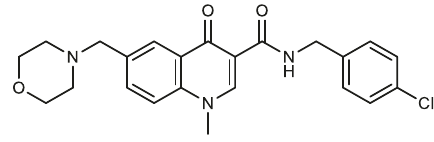
Fig. 1 Chemical structure of PNU-183792. PNU-183792 is a non- nucleoside inhibitor of herpesvirus